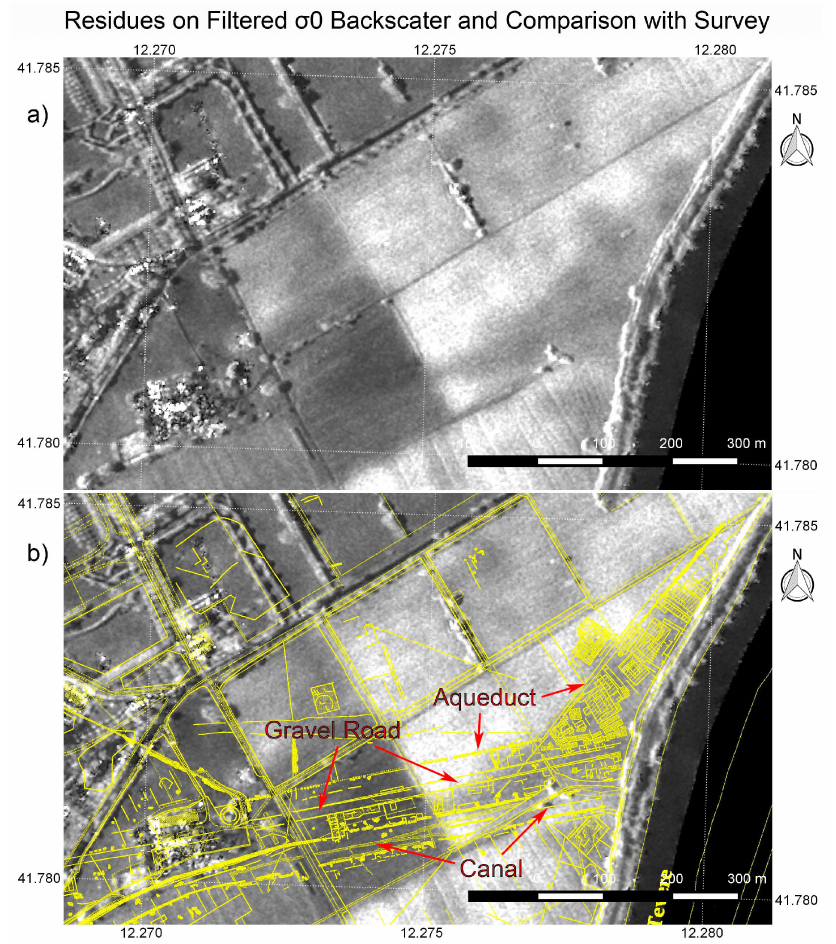
Figure 12. ( a ) Residue of buried buildings on image of filtered σ 0 backscatter acquired on 9 July